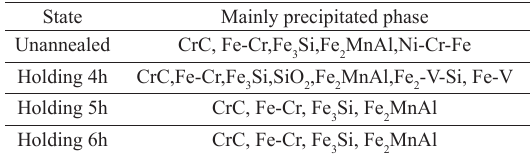
Table 3. The main precipitates in weld and base metal of P91 heat resistant steel under different holding time State Mainly precipitated